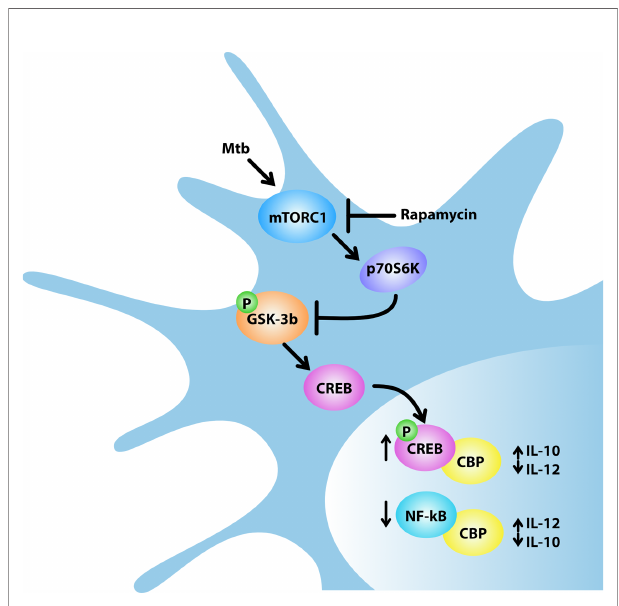
FIGURE 9 | Model for rapamycin-triggered cytokine regulation during Mtb infection. Mtb infection of human DC activates mTORC1/p70S6K axis that phosphorylates and, in turn, inhibits the multifunctional protein kinase GSK- 3 b . The mTORC1/p70S6K-mediated suppression of GSK-3 b favors the nuclear translocation of CREB and in turn its binding to the coactivator of transcription CBP, while it reduces the amount of NF-kB p65 associated with CBP. In Mtb-infected DC, rapamycin, by blocking mTORC1, prevents GSK- 3 b inhibition thus impinging on IL-12/IL-10 expression and